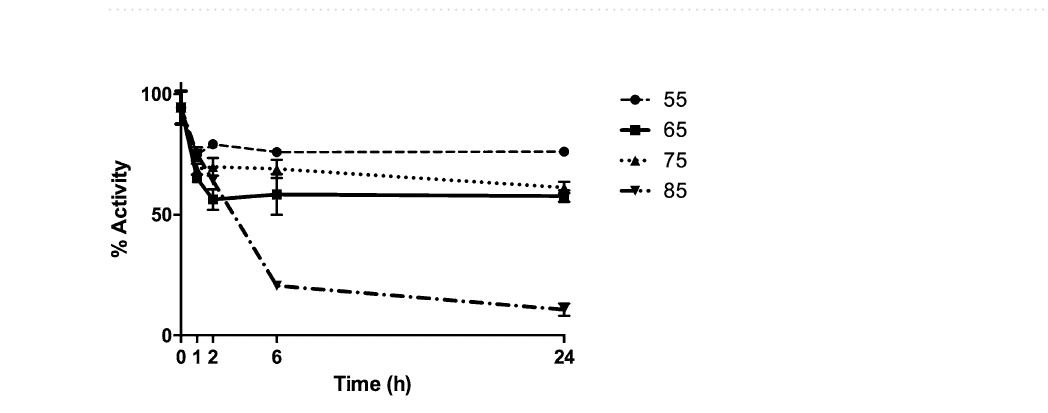
Figure 3. Effect of pH ( A ) and temperature ( B ) on the activity of pTsbg in Z Buffer using ONPG (4 mg mL −1 ) as substrate. Graphic was created using GraphPad Prism 6 for Windows (GraphPad Software, San Diego, California USA, www.graph pad.com).